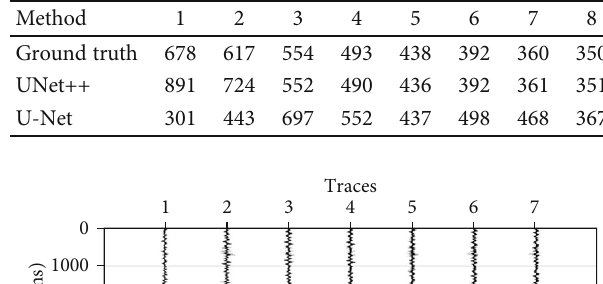
Figure 16: First-arrival picking results of the forward modeling pro fi le with -8-dB Gaussian noise added. (a) The noisy pro fi le formed by adding the Gaussian noise with the SNR of -8-dB to the pro fi le shown in Figure 6. (b) The noisy pro fi le intermediate features extracted by C5 layer of the UNet++. (c) First-arrival prediction results obtained by the UNet++ and the U-Net. Table 2: Result comparison of UNet++ and U-Net methods with the ground truth.